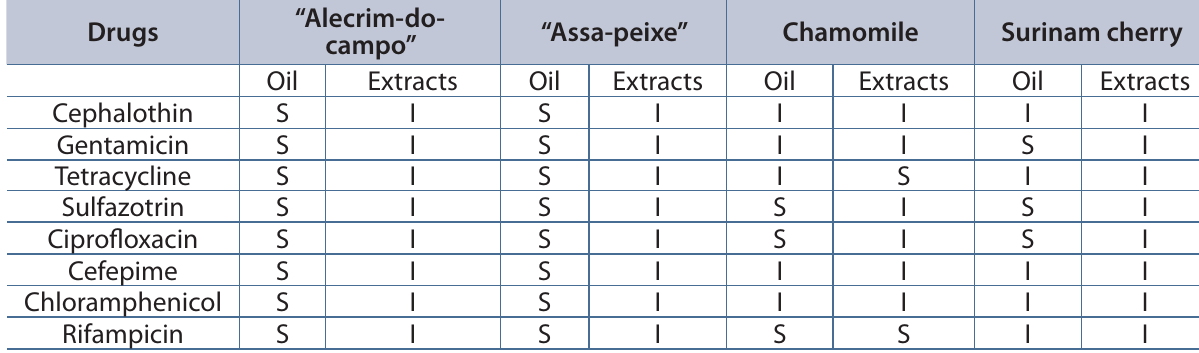
Table 1. Results of synergism between plant extracts or essential oils with antimicrobial agents against Staphylococcus aureus strains “Alecrim-do- Drugs “Assa-peixe” campo” Extracts Oil